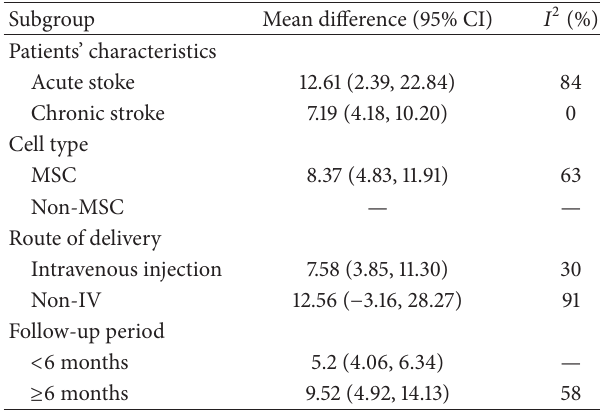
Table 4: The correlations of Barthel and clinical variables across studies by subgroup and heterogeneity